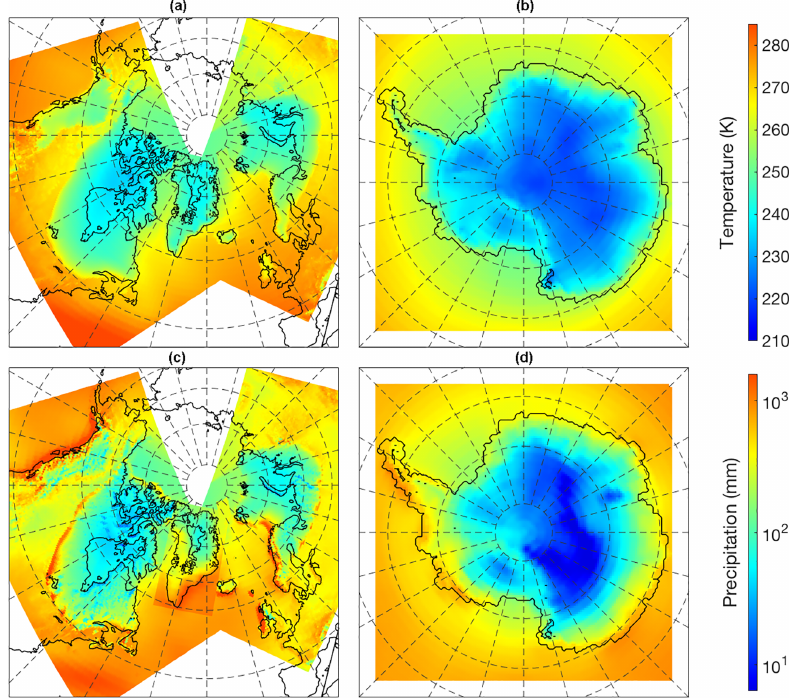
Figure A2. Annual mean 2m temperature for the Northern Hemisphere (a) and Antarctica (b) and the total annual precipitation (c, d) resulting from applying the constant lapse rate temperature change plus global offset and the Roe precipitation model to the ERA-40 climate fields and the ANICE LGM ice